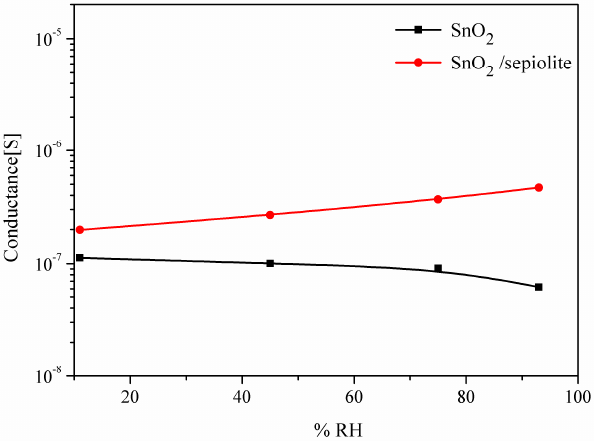
Figure 16. Changes in the conductance of the sensor without a filter and the sensor with a filter as a function of humidity at a temperature of 550 °C.